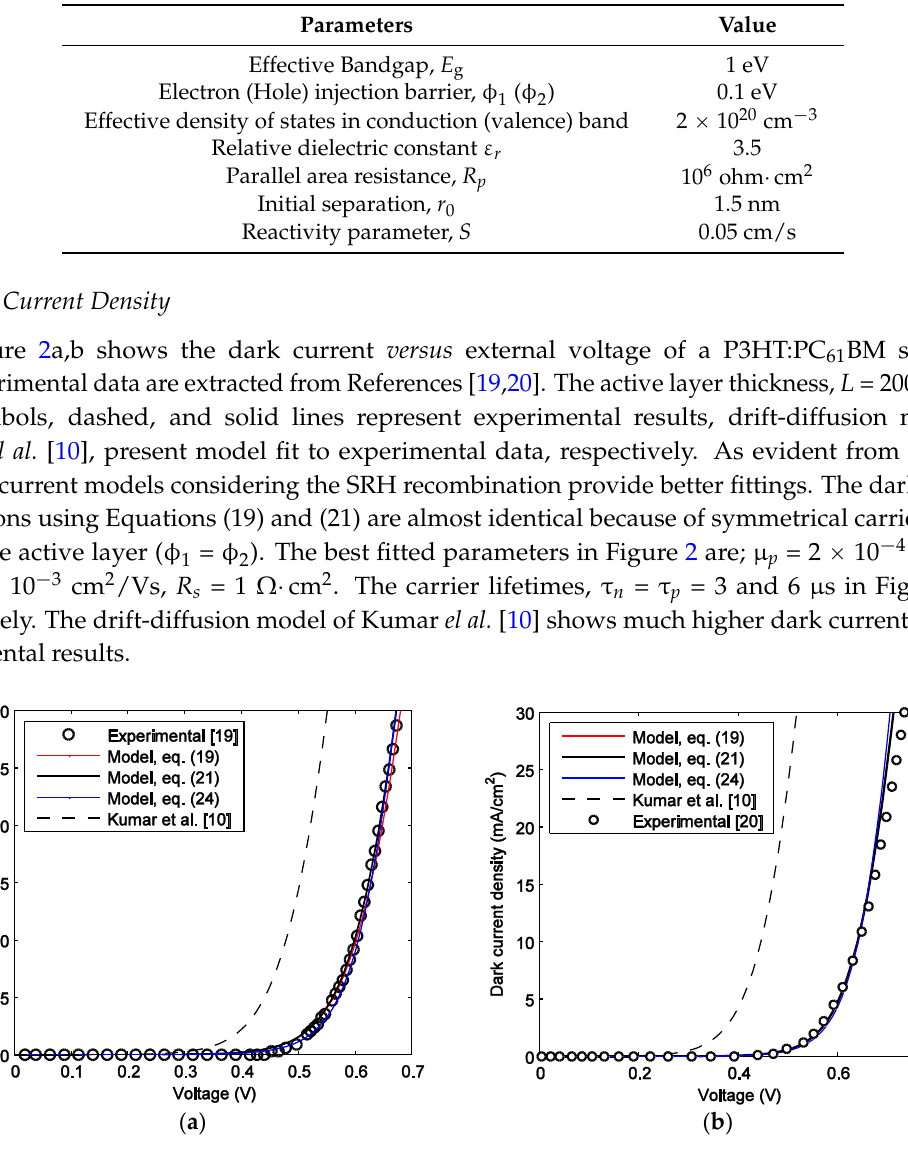
Figure 2. Dark current-voltage characteristics of P3HT:PCBM solar cells. ( a ) The experimental data